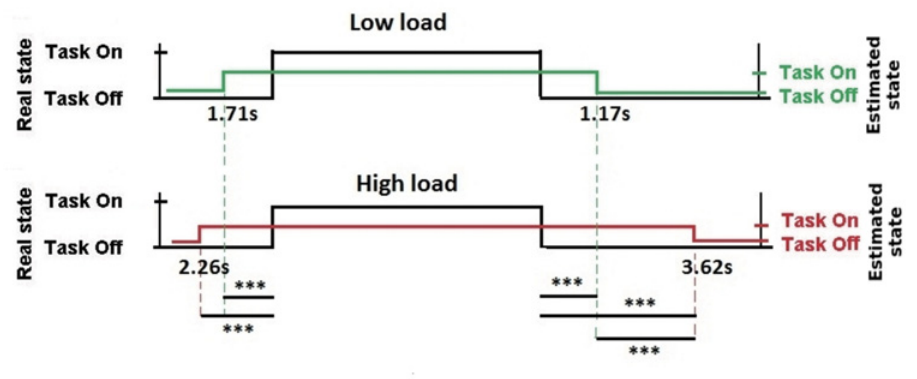
Fig 8. Off-line estimated onset and offset latencies compared to the stimuli onset, in low WM load and high WM load conditions. Average for 20 trials per difficulty, on 19 pilots ’ results. *** : p <